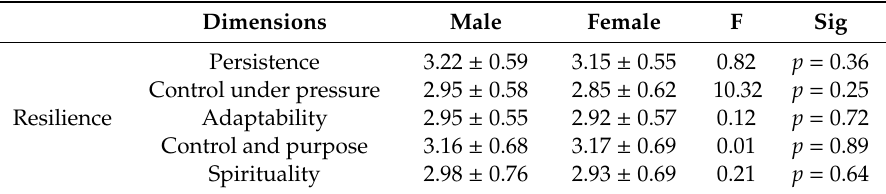
Table 2. Resilience levels according to